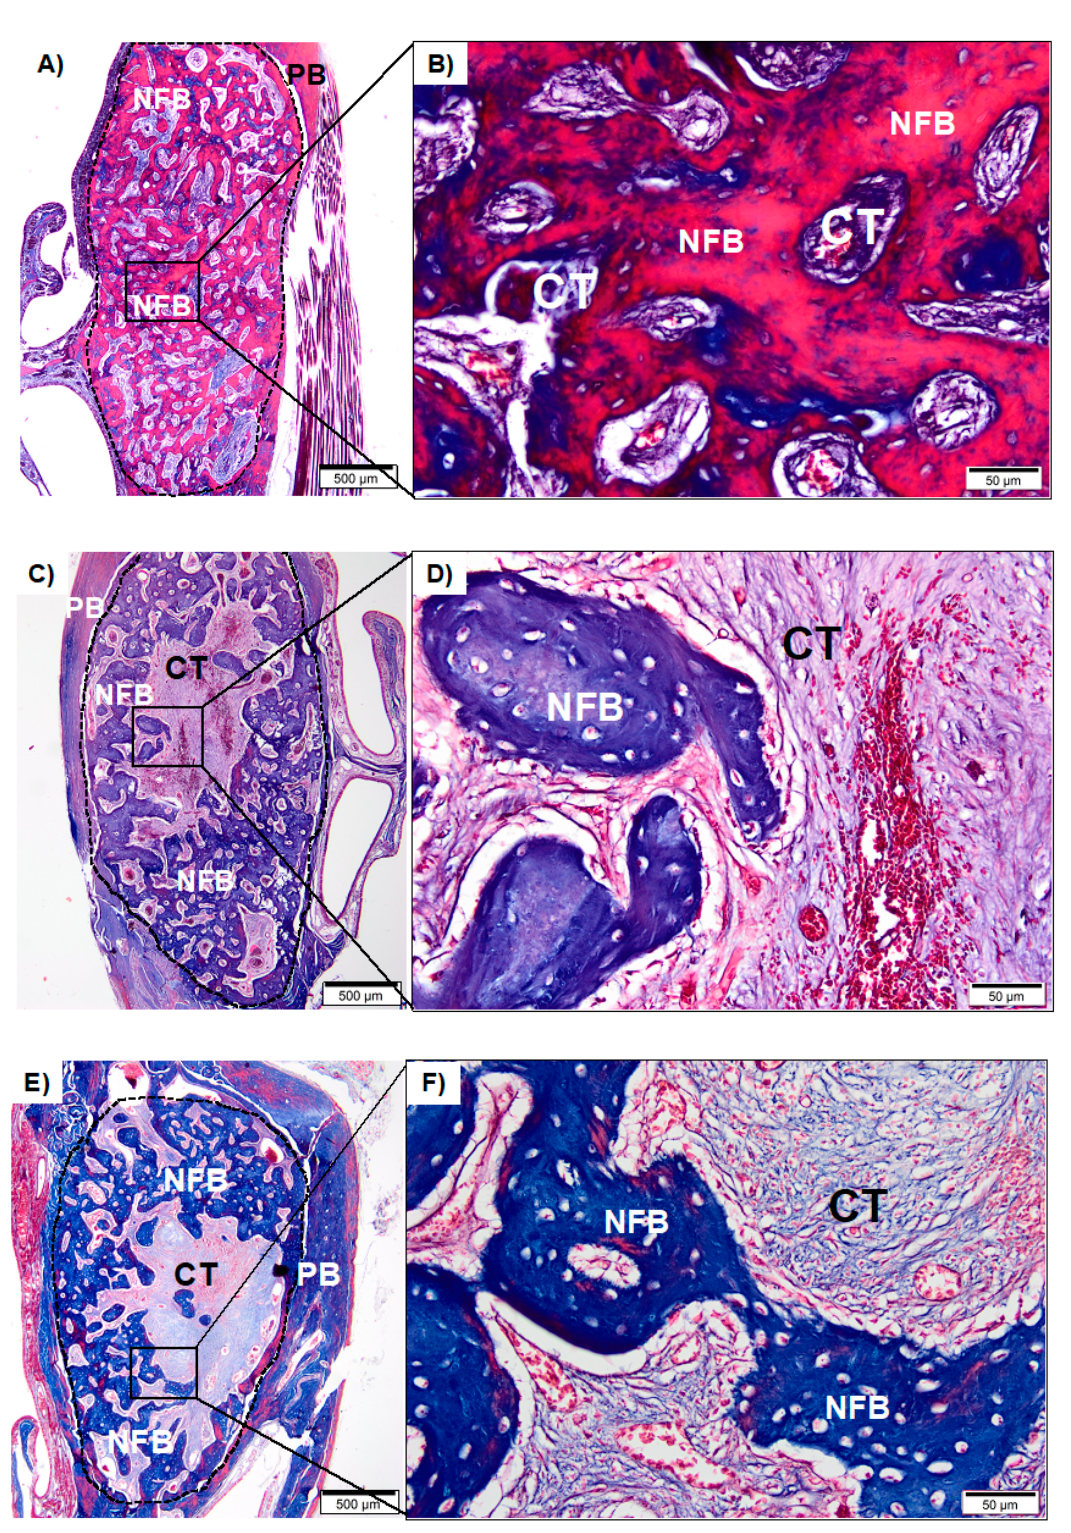
Figure 4. ( A ): Photomicrograph of Sham group (without ZA treatment) after 28 days at 20 × magnifi- cation. ( B ): Sham group in detail at 40 × magnification. ( C ): Photomicrograph of Sham 4% ZA after 28 days at 20 × magnification. ( D ): Sham 4% ZA in detail at 40 × magnification. ( E ): Photomicrographs of Sham 8% ZA after 28 days at 20 × magnification. ( F ): Sham 8% ZA in detail at 40 × magnification. Newly formed bone (NFB); connective tissue (CT) pre-existing bone (PB). ( A , C , E ): scale bar 500 µ m; ( B , D , F ): scale bar: 50 µ m. Staining with Masson’s